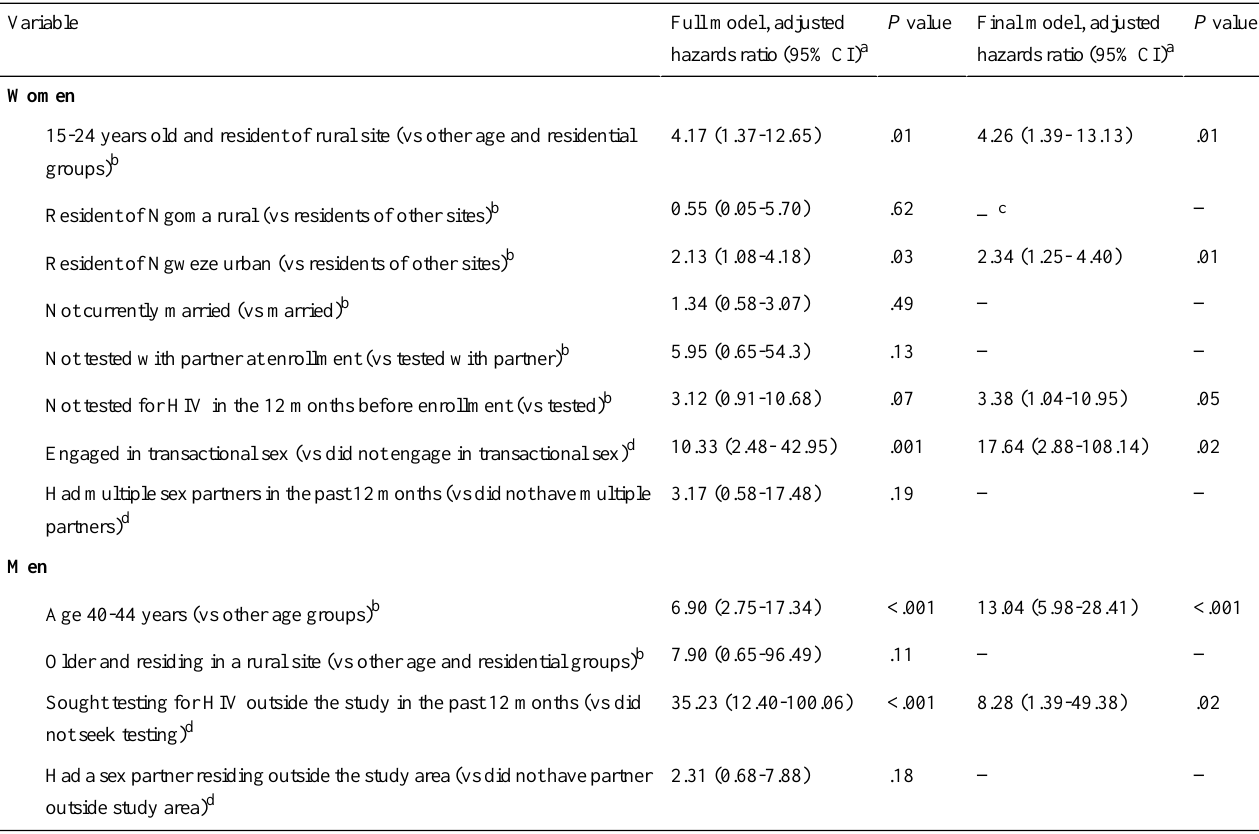
Table 3. Correlates of HIV seroconversion among women and men, multivariable Cox proportional hazards models, and household cohort study